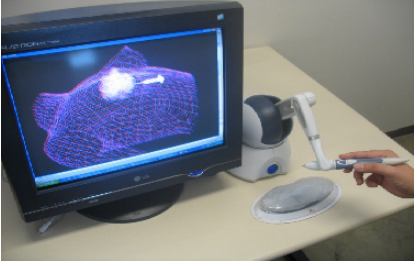
Fig. 3. User interacting with a video-avatar of a remote